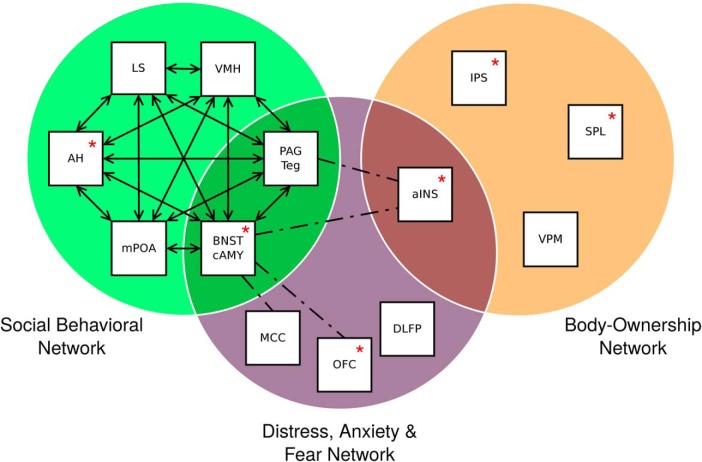
Networks related to key dimensions of gender dysphoria. Each box represents nuclei or brain regions involved in these networks. Red asterisks are included in boxes where the following regions/nuclei have known anatomic changes associated with transgender individuals (Smith et al., 2015; Guillamon et al., 2016; Altinay and Anand, 2019): anterior hypothalamus (AH; Garcia-Falgueras and Swaab, 2008); BNST (Zhou et al., 1995); anterior insula (aINS) and orbitofrontal cortex (OFC; Zubiaurre-Elorza et al., 2013); superior parietal lobe (SPL; Lin et al., 2014); and intraparietal sulcus (IPS; Case et al., 2017). Connections are based on the studies by Kong et al. (2010), Newman (1999), and Tillman et al. (2018). AH, Anterior hypothalamus; cAMY, central amygdala; DLPF, dorsolateral prefrontal cortex; LS, lateral septum; MCC, mid-cingulate cortex; mPOA, medial preoptic area; PAG, periaqueductal gray; Teg, tegmentum; VPM, ventral premotor cortex. Solid lines with arrows represent anatomical connections, while dash-dotted lines represent known functional connections.